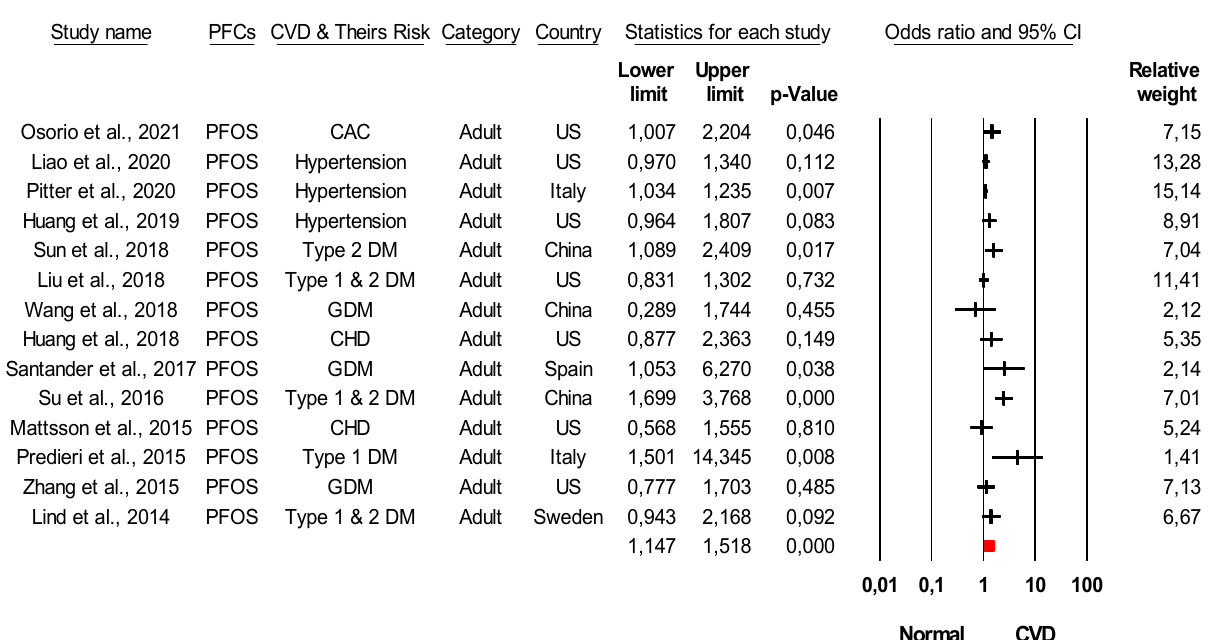
Figure 6. Meta-analysis of studies of PFOS exposure and CVDs and their risk using the random-effects model, ordered by date of publication. Stratified analysis of PFOS as the unit of analysis within the study was selected. CAC = coronary artery calcium, DM = diabetes mellitus, GDM = gestational diabetes mellitus, CHD = coronary heart diseases. Test for overall effect: z = 3.87, p < 0.0001; Test for heterogeneity: I 2 = 60.13 Q = 32.66 df = 13, p < 0.0001.